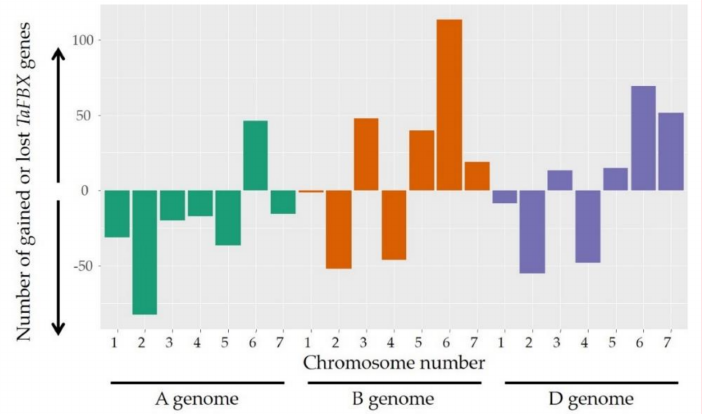
Figure 1. TaFBX gene excess and deficit among the 21 wheat chromosomes. The gene excess or deficit was calculated as a subtraction of the observed TaFBX number from the expected